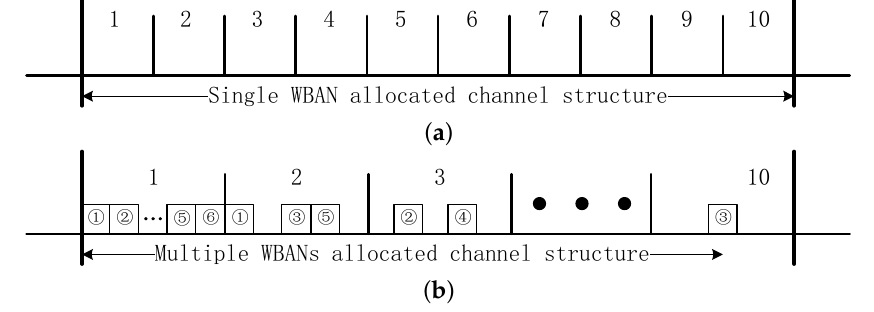
Figure 1. Channel structure illustration with the number of channels equaling 10. ( a ) 1-tolerated channel conflict model; ( b ) m -tolerated channel conflict